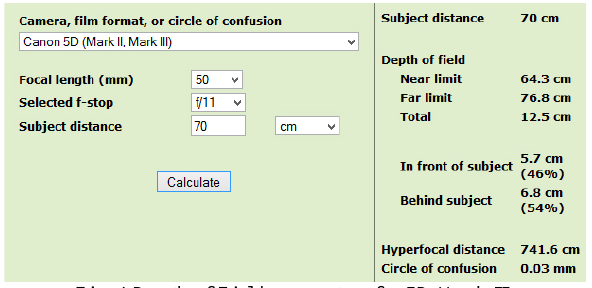
Fig. 4 Depth of Field parameters for 5D Mark II.